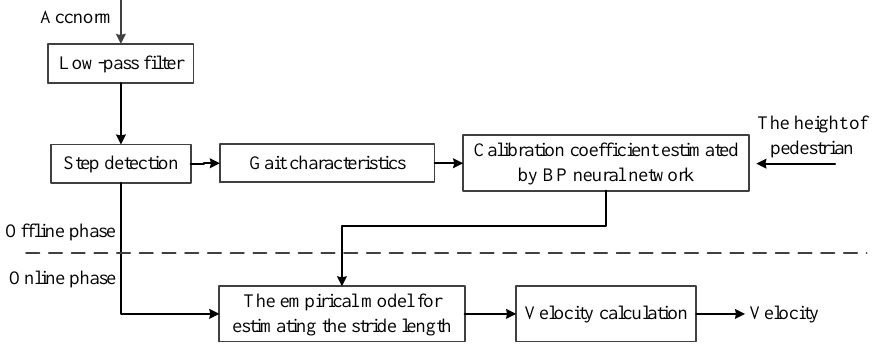
Figure 2. Block diagram of velocity